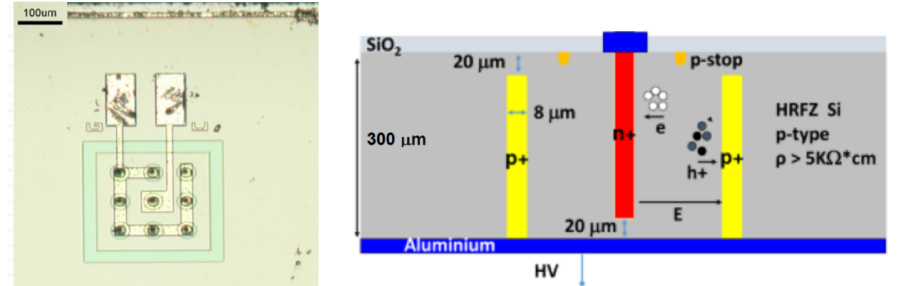
Figure 1. Schematic view from top of a single cell structure ( left ). Cross section of a single cell structure ( right ) [4].